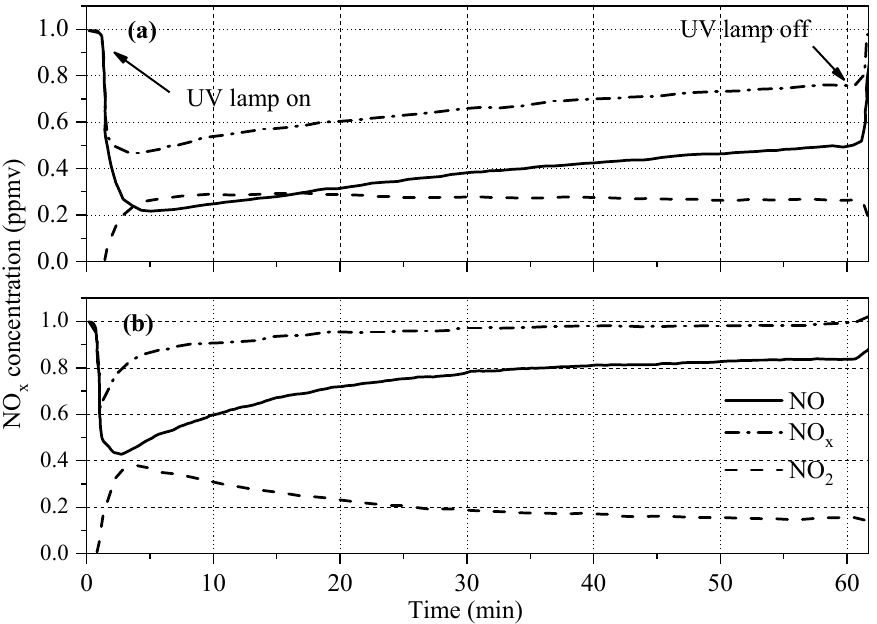
Figure 6. Removal of NO x under UV irradiation over ( a ) P25 and ( b ) A-TiO 2 NPs. Table 3. Average NO removal and NO 2 generation rates for the prepared